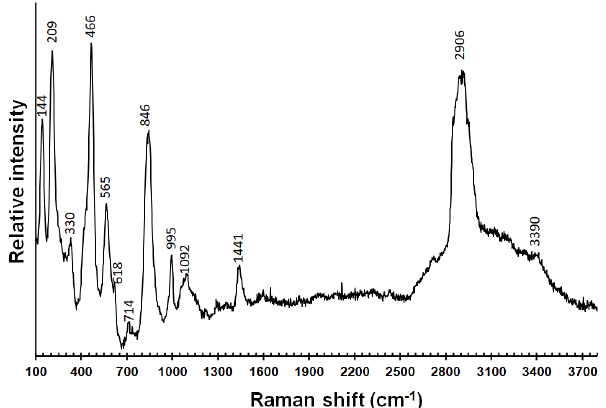
man band of silicon before each experimental session. Spec-